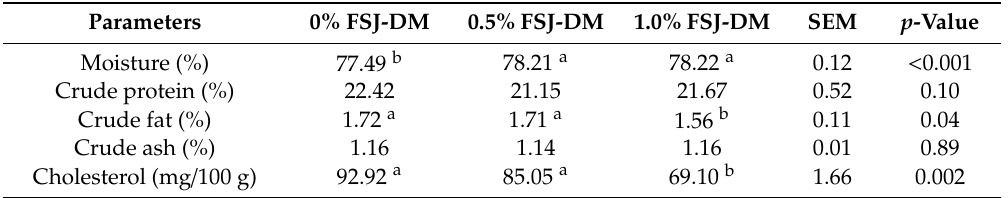
Table 6. Proximate composition and cholesterol content of gluteus medius muscle from KNBG